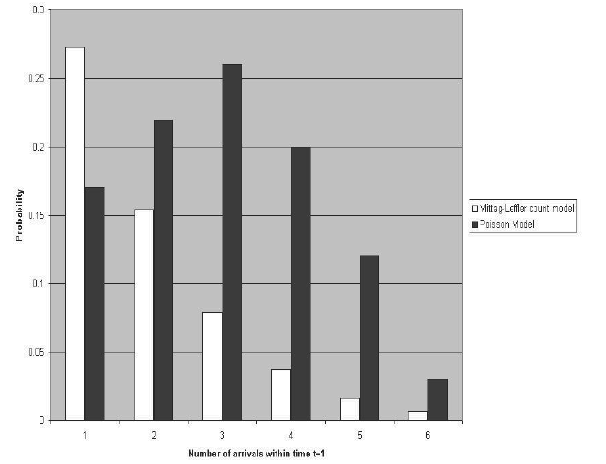
Figure 3 – Probability histogram of Mittag-Leffler count model ( α =0.5) and Poisson model ( λ